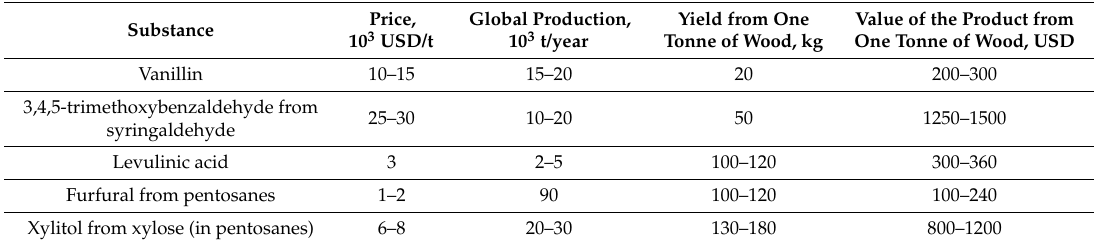
Table 5. Market figures for the products of birch wood